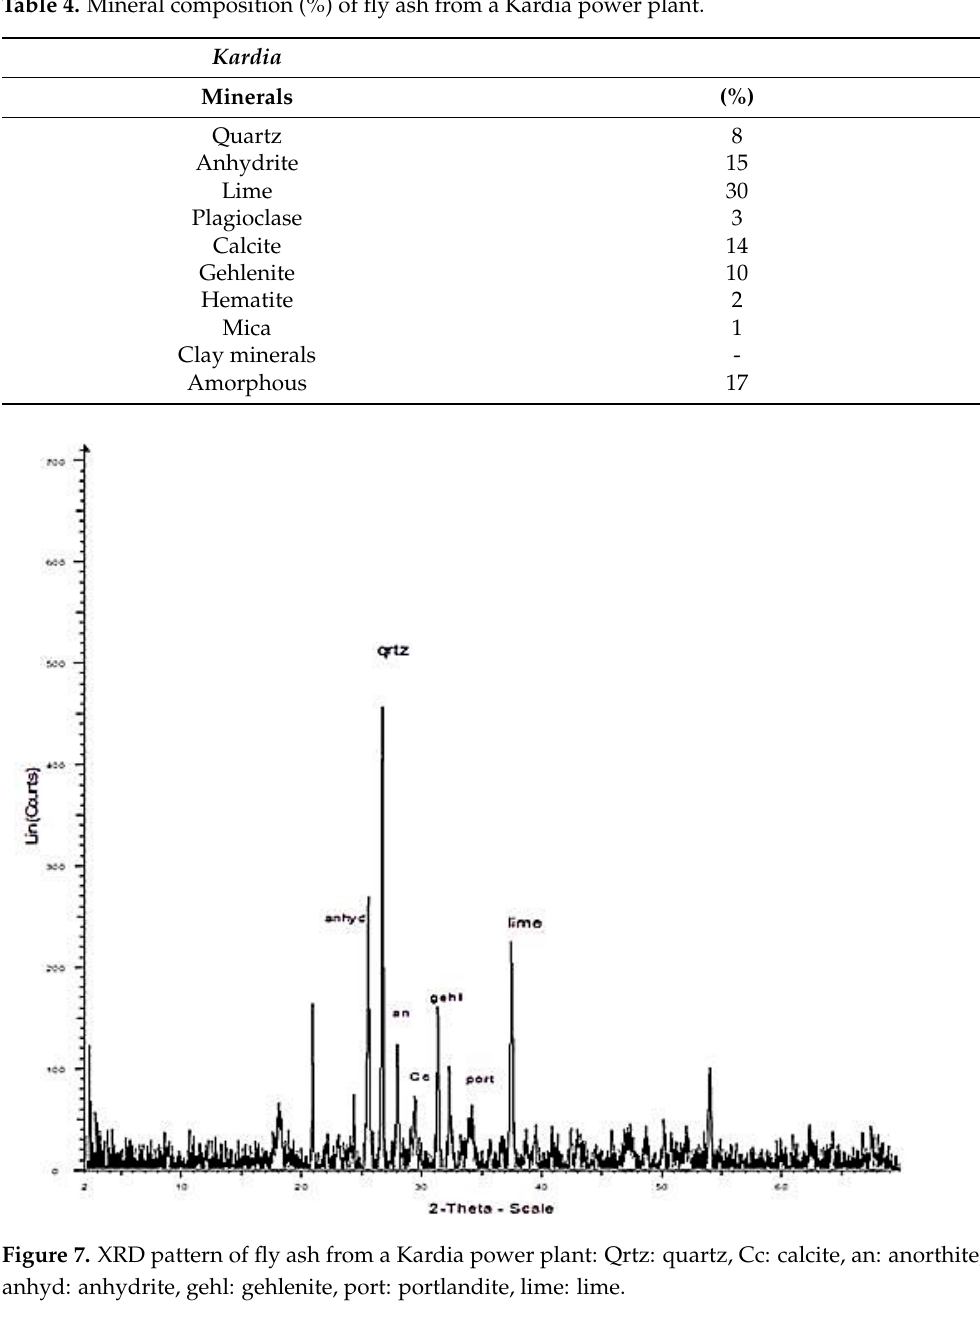
Table 4. Mineral composition (%) of fly ash from a Kardia power plant.